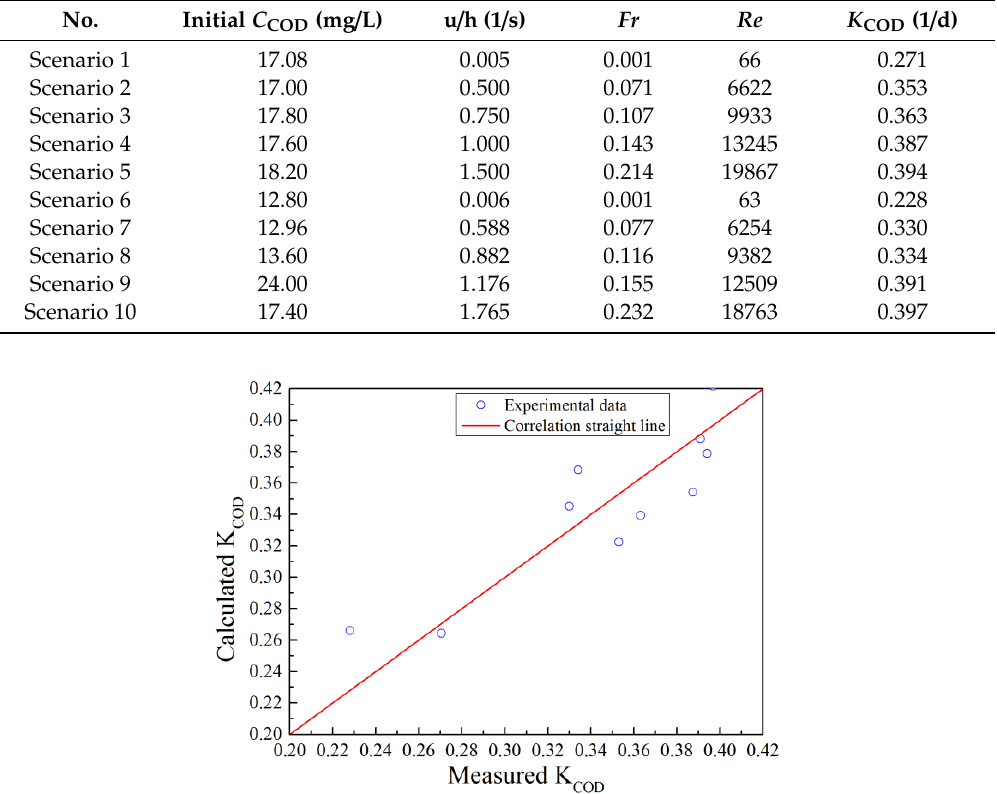
Figure 5. Comparison of the measured and calculated values of the COD degradation coefficient.